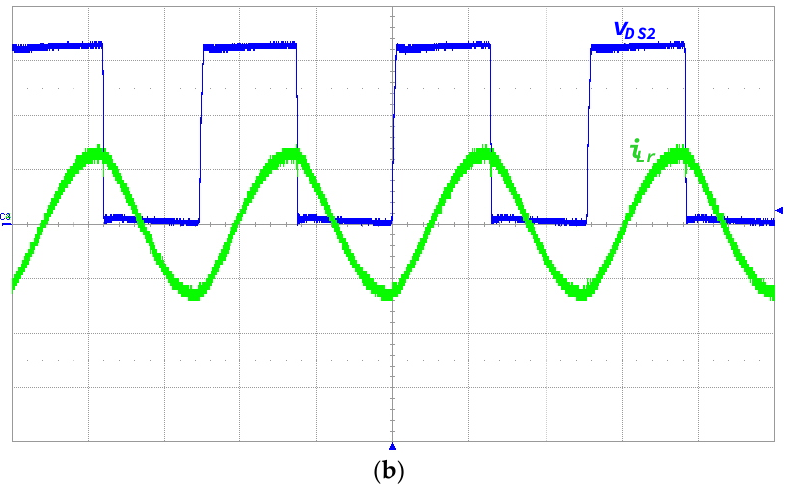
Figure 17. ( a ) Simulated and ( b ) measured switch voltage v DS2 (200 V/div) and resonant inductor current i Lr (1 A/div); time scale: 10 μs/div.